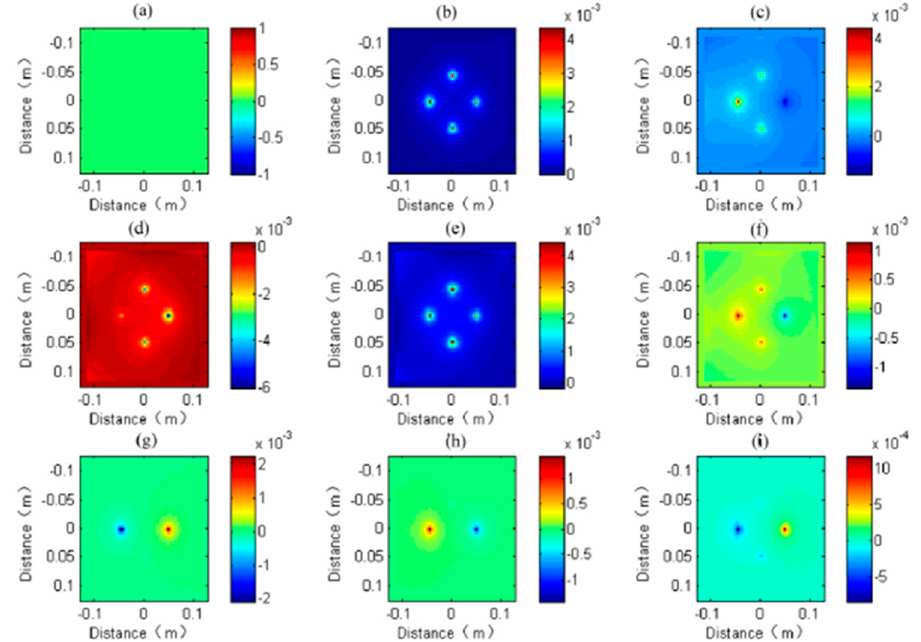
Figure 10. Wave field snapshots in subgrid region, ( a ) 17 ns, ( b ) 34 ns, ( c ) 66 ns, ( d ) 76 ns, ( e ) 86 ns, ( f ) 96 ns, ( g ) 116 ns, ( h ) 136 ns, ( i ) 156 ns.